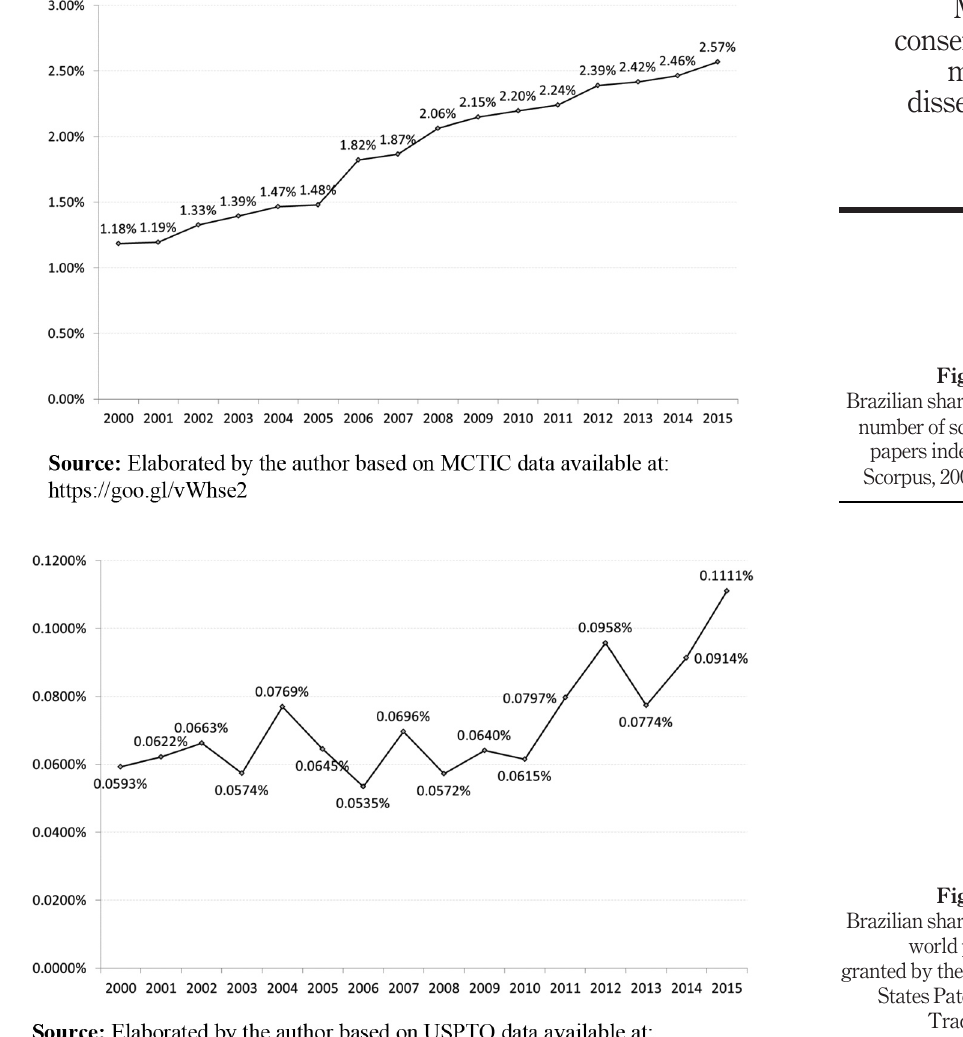
Figure 3. Brazilian share in